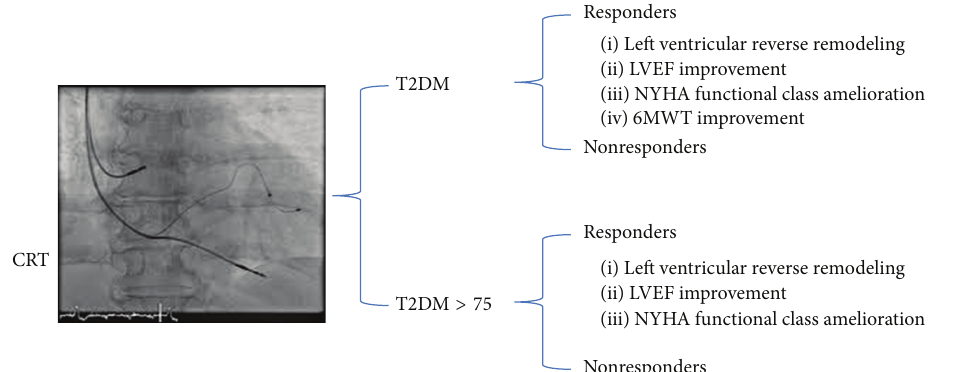
Figure 1: In this figure, the representation of CRT (cardiac resynchronization therapy) effect on T2DM (type 2 diabetes mellitus) and T2DM > 75 (type 2 diabetes mellitus older than 75 years) patients. In radioscopic image three catheters were placed in right atrial appendage (10 o’clock), right ventricular apex (5 o’clock), and coronary sinus lateral vein (3 o’clock). This is an example of biventricular pacing for cardiac resynchronization therapy. In responders there is a left ventricular reverse remodeling, a left ventricle ejection fraction (LVEF) improvement, an amelioration in New York Heart Association (NYHA) functional class, and 6 minutes walking test (6MWT) improvement. This last parameter (6MWT) is not improved in T2DM >